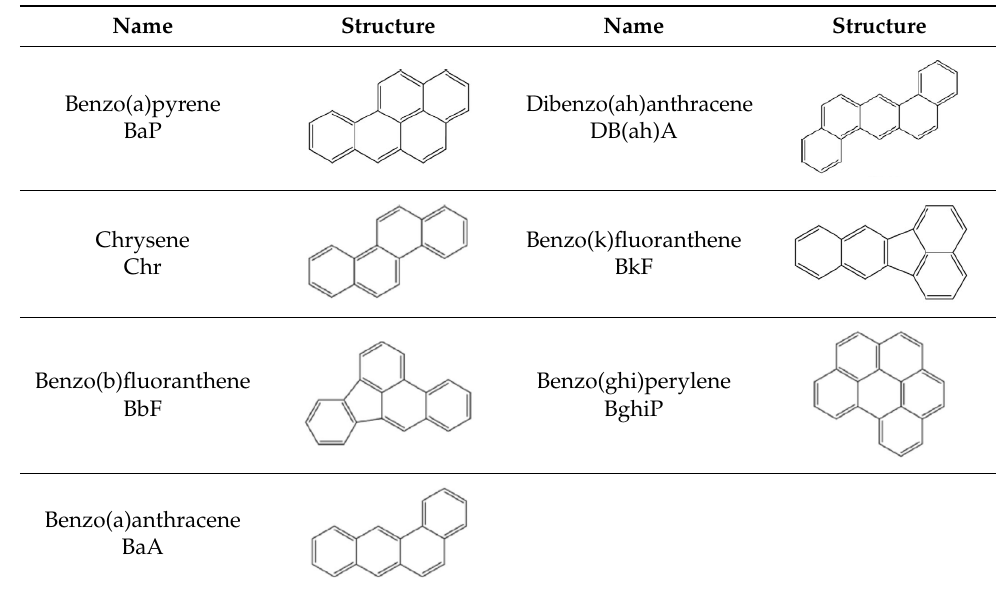
Table 1. Names and structures of the PAHs determined in this study.